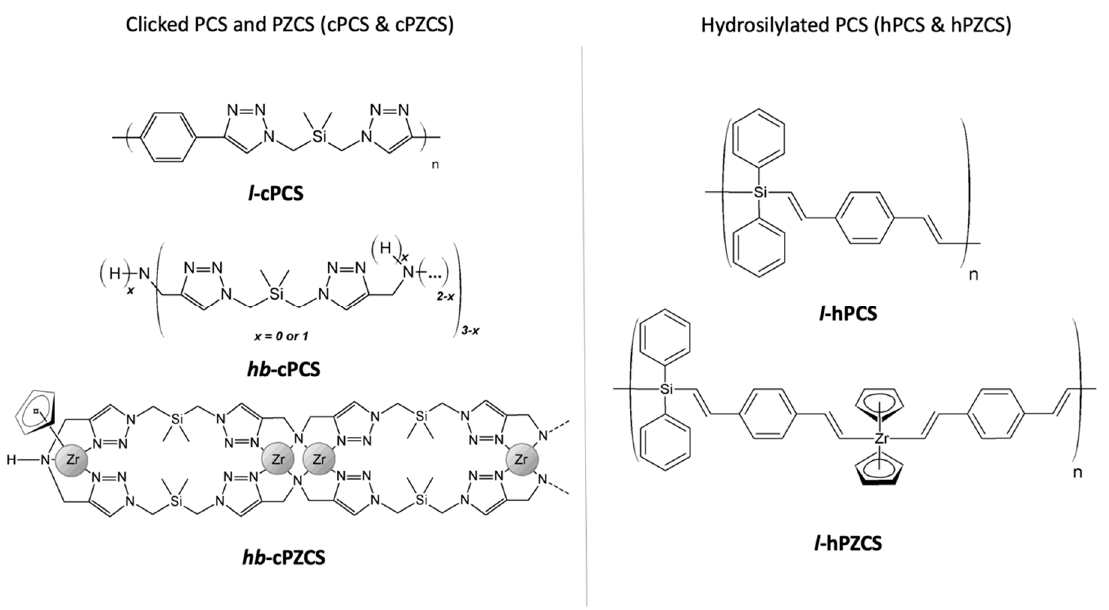
Figure 2. Different preceramic precursors synthesised by polycycloaddition (left) or polyhydrosilylation/polyhydrozirconation (right). To simplify the hypothetical hb- cPZCS formula, no charges or oxidation states are indicated.